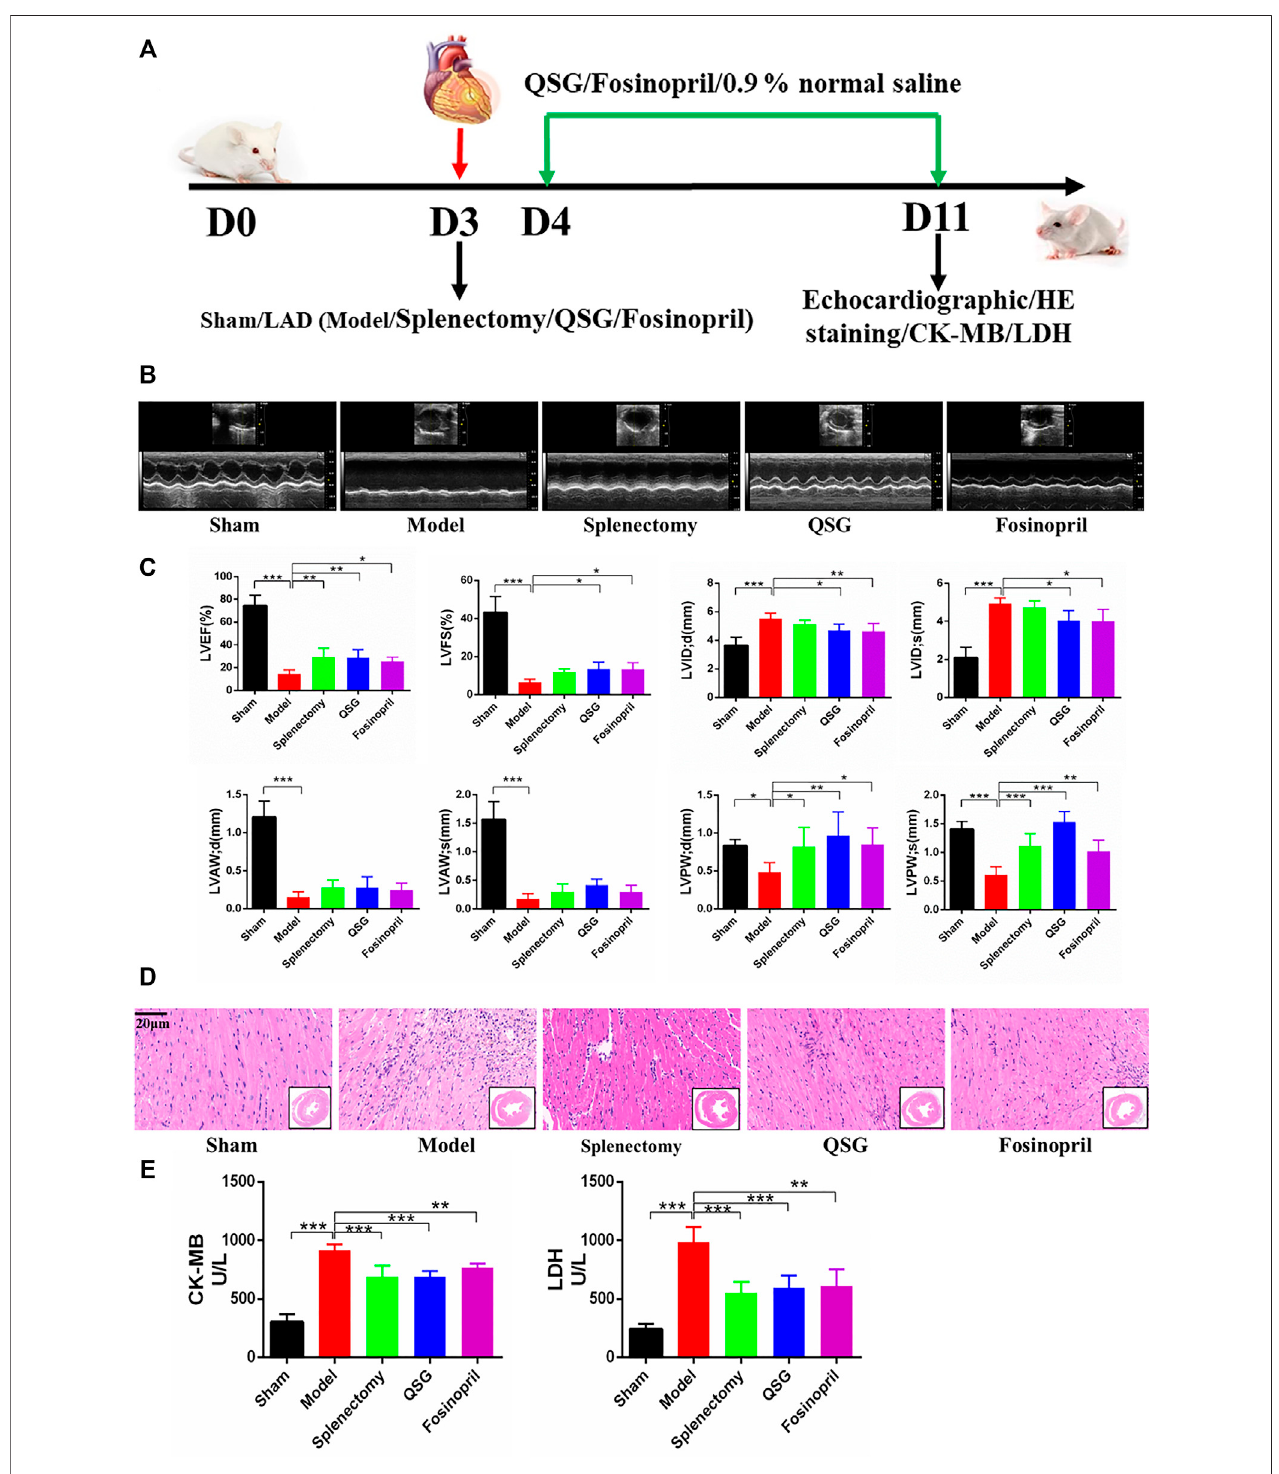
FIGURE1| QSGimprovedcardiacfunctionandreducedpathologicalchangesinHFmice. (A) ExperimentalprotocolforQSGstudiesinAMI-inducedHFmice. (B) RepresentativeM-modeechocardiographicimagesofmiceineachgroup. (C) EvaluationofLVEF,LVFS,LVID;d,LVID;s,LVAW;d,LVAW;s,LVPW;d,LVPW;slevelsin eachgroupbyechocardiography.N=6pergroup. (D) RepresentativeimagesofHEstainingineachgroup.Scalebar=20 µm. (E) ThelevelofCK-MBandLDHinserum from each group. N = 5 per group. * p < 0.05, ** p < 0.01, *** p < 0.001 vs. model group.